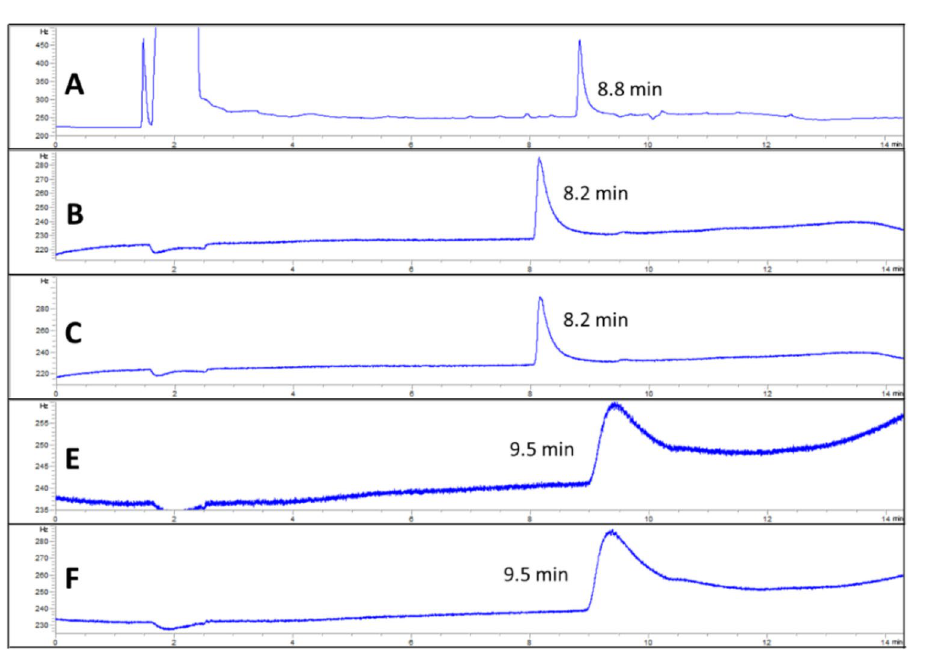
Figure 2. Hexaconazole (5.0 ng/mL) peak comparison in the solvent ( A ) MeCN and matrix of ( B ) CPO, ( C ) CPKO, ( D ) leaf and ( E )